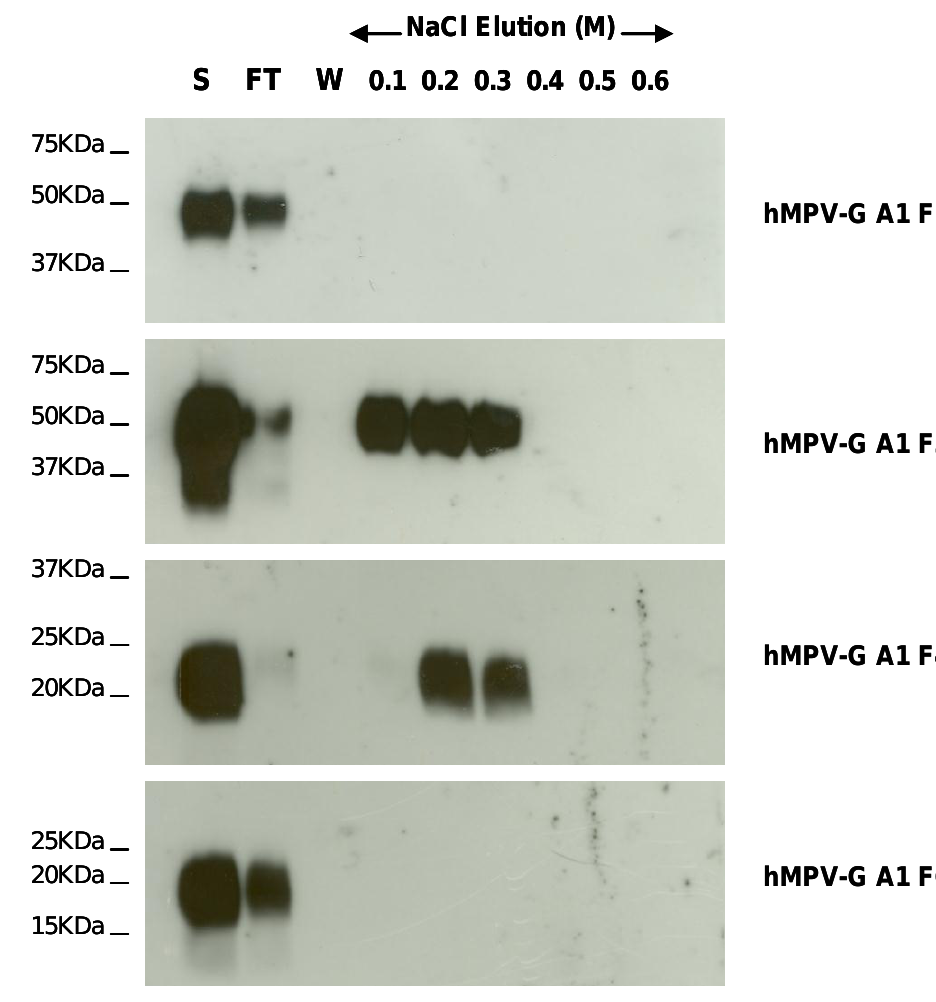
Figure 5. Heparin agarose affinity chromatography of recombinant F2, F3, F4, and F6 fragments of the hMPV G A1 strain ectodomain. The start (S), flow through (FT), final wash (W) and salt elution fractions were analysed by 10%–14% SDS-PAGE under reducing conditions and western blot analysis using anti-c-Myc